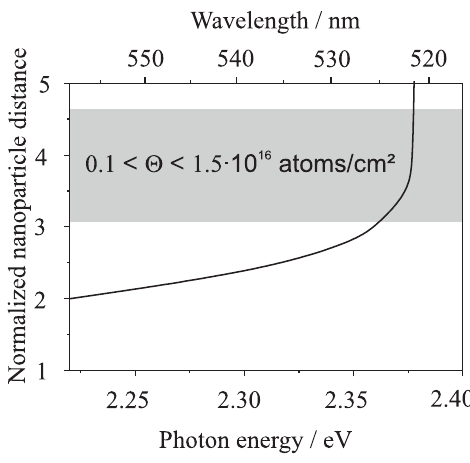
Figure 4. Photon energy of the plasmon resonance versus normalized nanoparticle distance. The shaded area indicates the coverages used in this